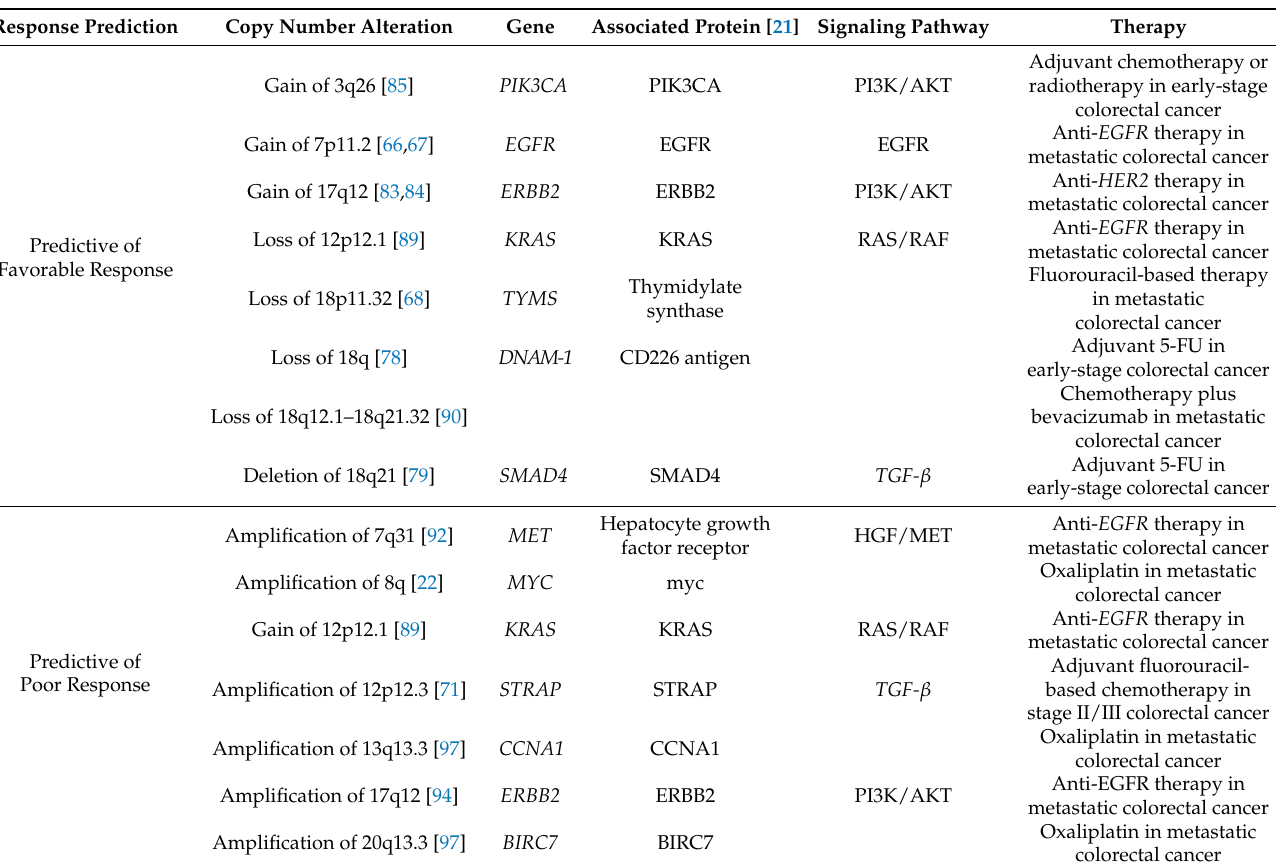
Table 3. Copy number alterations and their associated genes and functions with predictive roles in colorectal